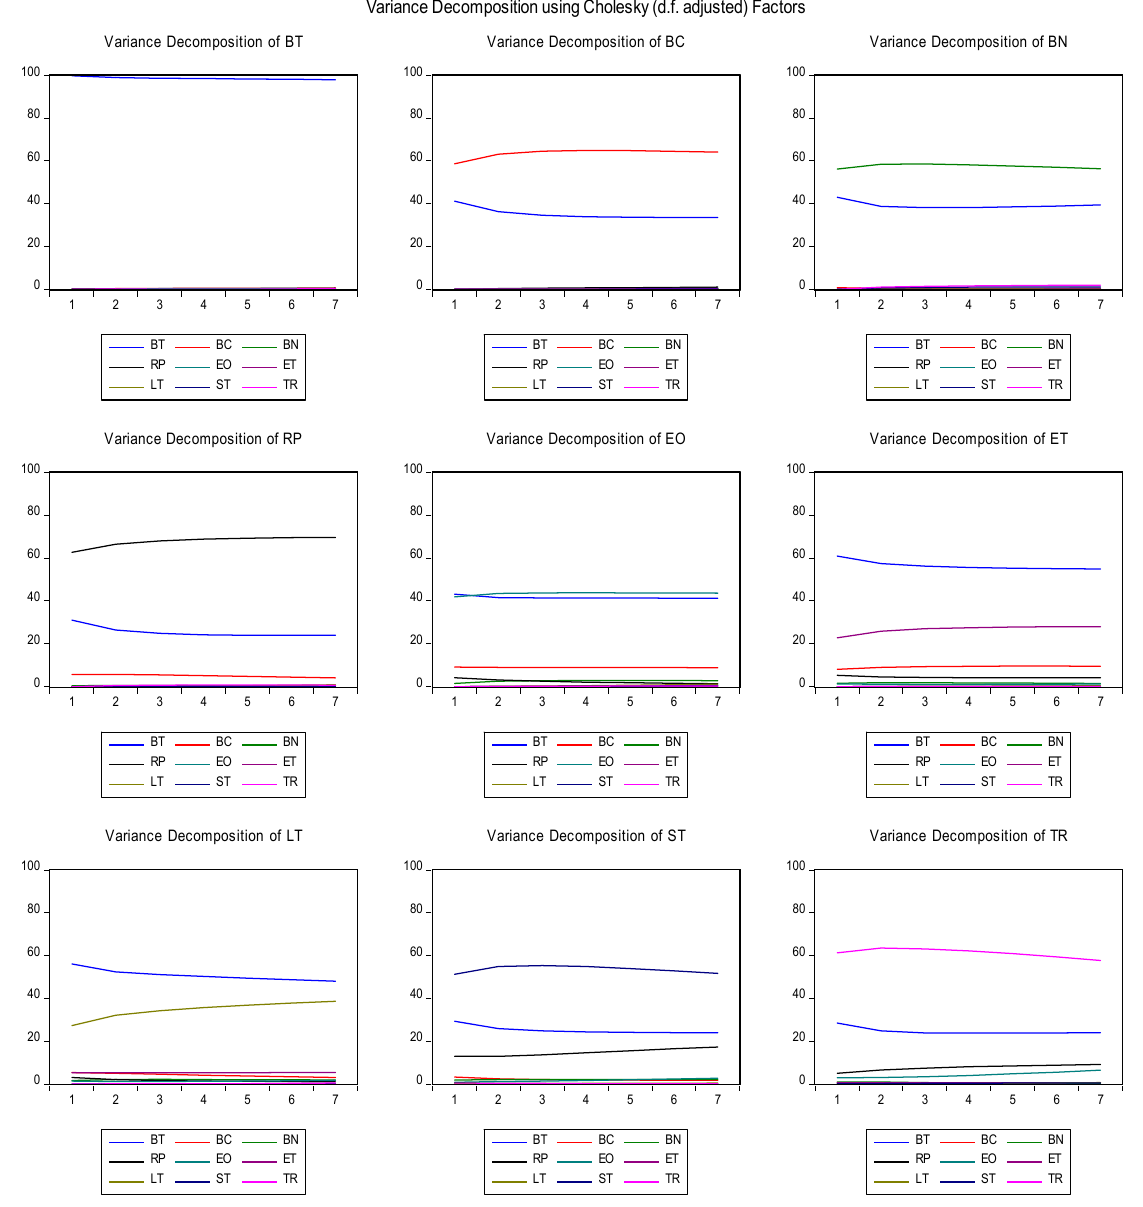
Figure 2. Variance decomposition in presence of